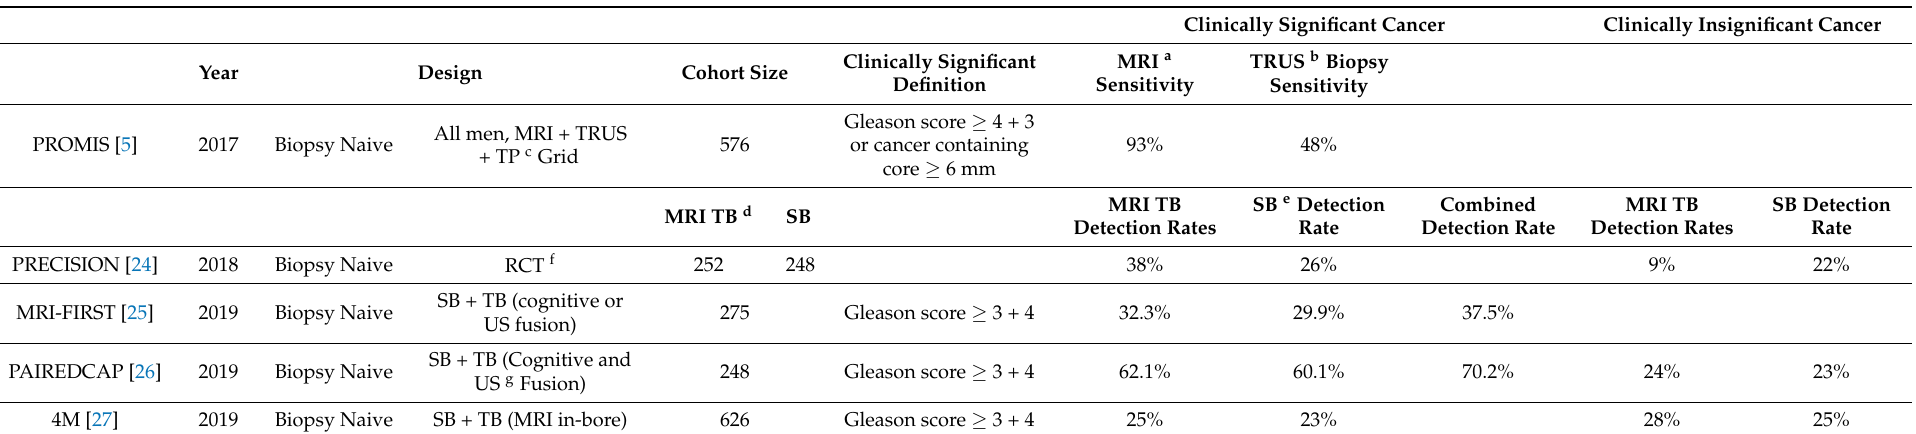
Table 1. Summary of key trials examining mpMRI is prostate cancer